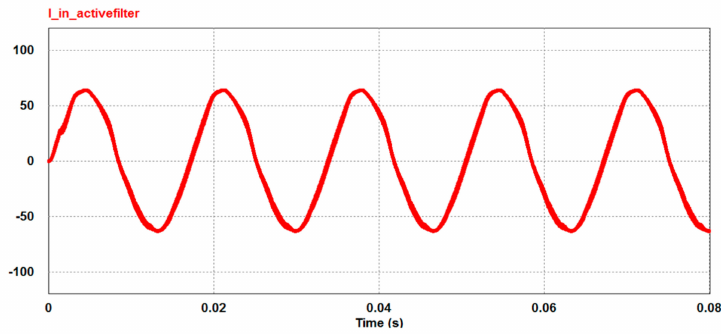
Figure 10. Waveform of the input phase current of the IH equipment with an SAF.